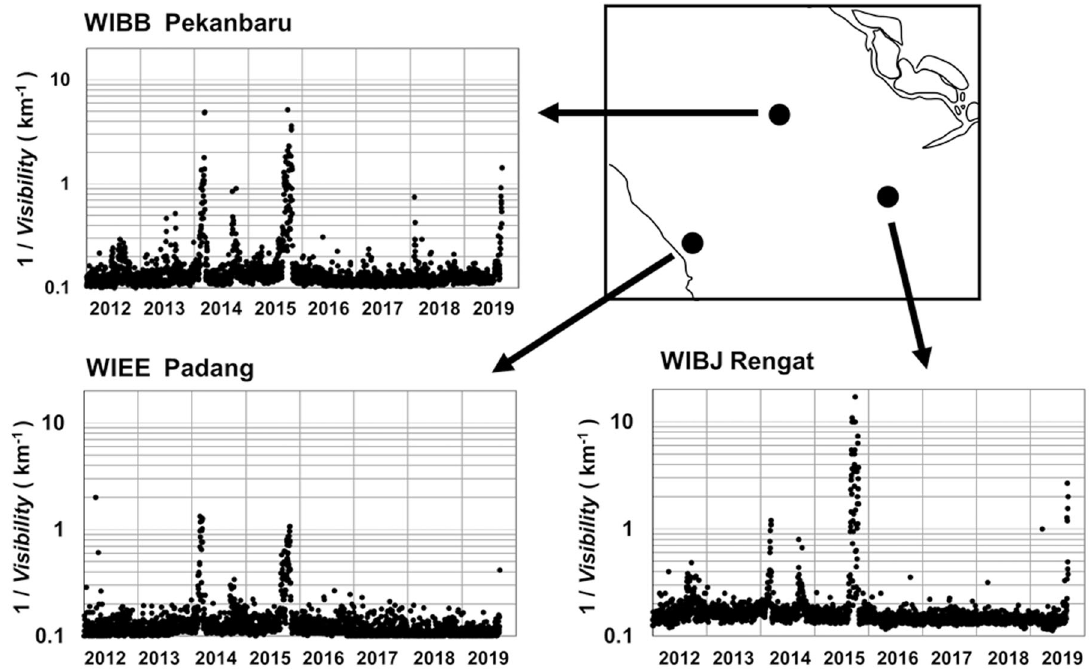
Fig. 7 Spatiotemporal variations of the reverse values of visibility on a logarithmic scale for three BMKG stations. Pekanbaru, Padang, and Rengat in the central region of Sumatra. The abbreviations are the station names of World Meteorological